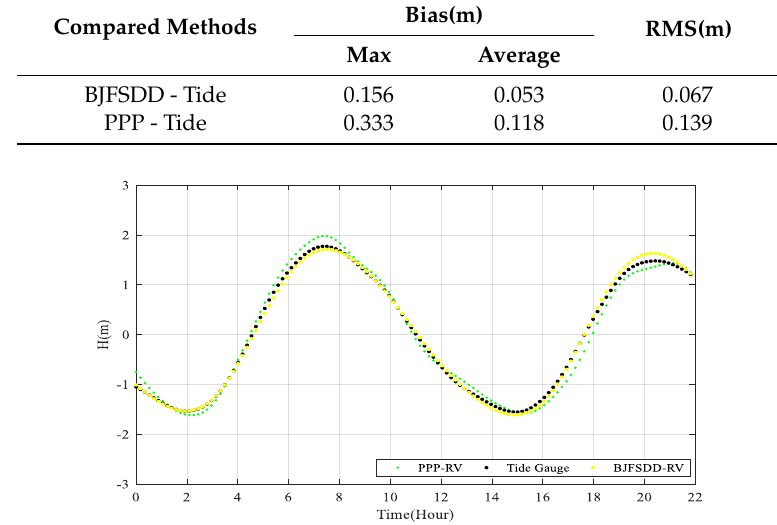
Table 5. Accuracy of the DD tide based on the BJFS and PPP tide with reference to tide gauge data. Compared Methods